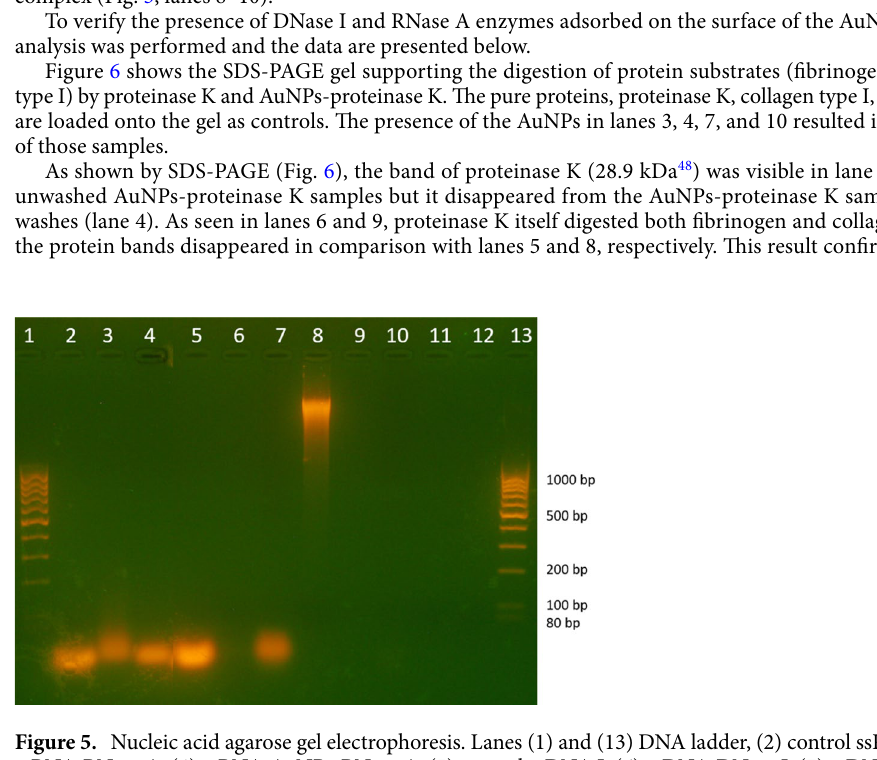
Figure 5. Nucleic acid agarose gel electrophoresis. Lanes (1) and (13) DNA ladder, (2) control ssRNA, (3) ssRNA-RNase A, (4) ssRNA-AuNPs-RNase A, (5) control ssDNA I, (6) ssDNA-DNase I, (7) ssDNA-AuNPs-